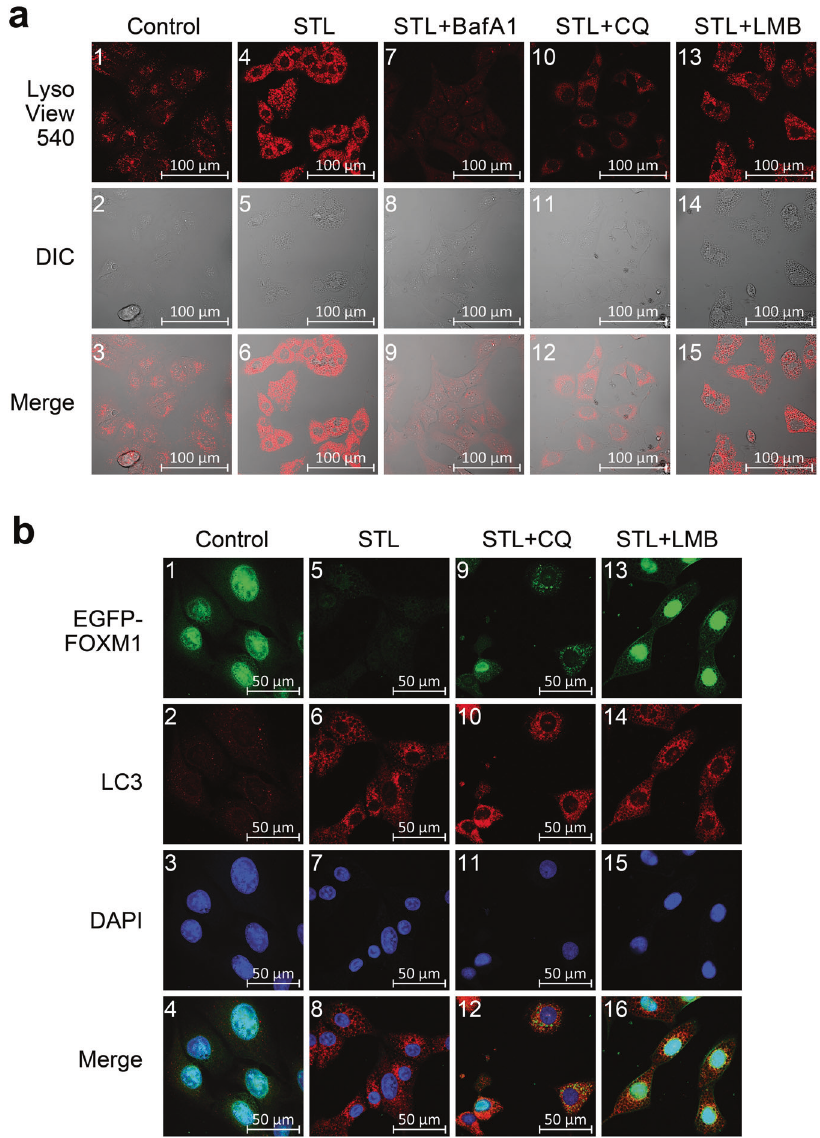
Fig. 4 STL promotes active lysosome formation and FOXM1 translocation from the nucleus to the cytoplasmic autophagosomes. a Doxycycline - stimulated C3-luc cells expressing EGFP-FOXM1 fusion protein were treated with vehicle ( “ Control ” , panels 1 – 3), 50 μ M STL alone ( “ STL ” , panels 4 – 6), or 50 μ M STL in combinations with 25 nM BafA1 ( “ STL + BafA1 ” , panels 7 – 9), 40 μ M CQ ( “ STL + CQ ” , panels 10 – 12), and 25 nM LMB ( “ STL + LMB ” , panels 13 – 15) for 12 h. Lysosomes were stained with vital LysoView 540 dye (red), cell morphology was analyzed using differential interference contrast (DIC) microscopy. b Doxycycline-stimulated C3-luc cells were treated with vehicle ( “ Control ” , panels 1 – 4), 50 μ M STL alone ( “ STL ” , panels 5 – 8), or 50 μ M STL in combinations with 40 μ M CQ ( “ STL + CQ ” , panels 9 – 12) and 25 nM LMB ( “ STL + LMB ” ,